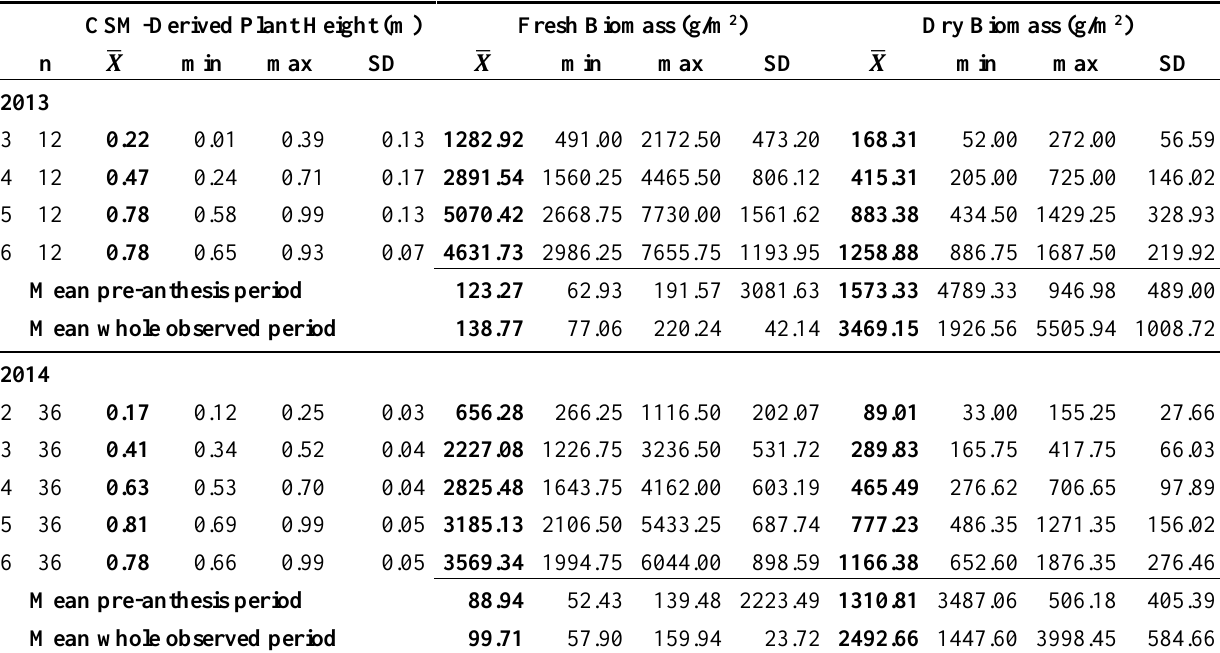
Table 4. Statistics for the plot-wise averaged CSM-derived plant heights and destructively taken biomass for the reduced data sets of 2013 and 2014 (n: number of samples; 𝑋̅ : mean value; min: minimum; max: maximum; SD: standard